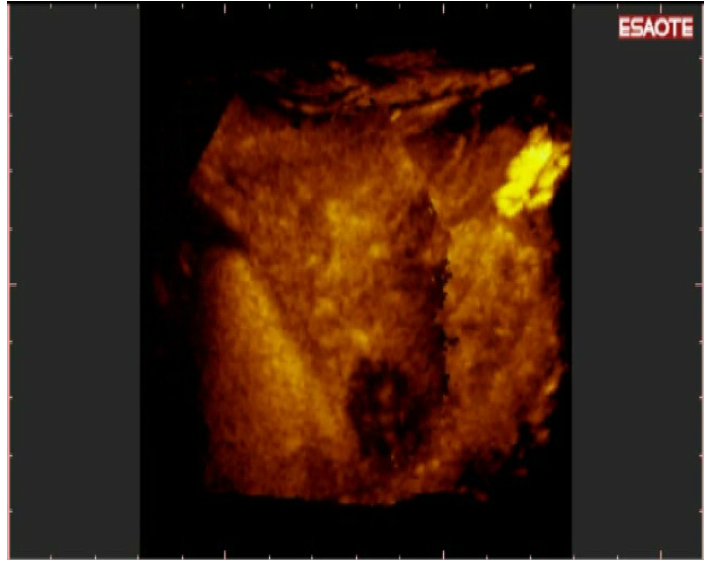
Figure 8. The liver volume can be studied “plane by plane” with reslicing technique, able to show a previously treated HCC of the VII segment in the same